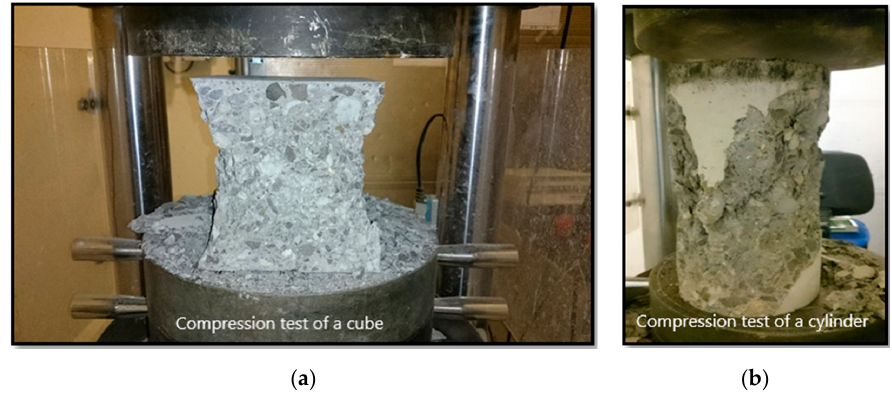
Figure 3. Failure modes of concrete cube and concrete cylinders failure: ( a ) Concrete cube failure mode; ( b ) Concrete cylinder failure mode.